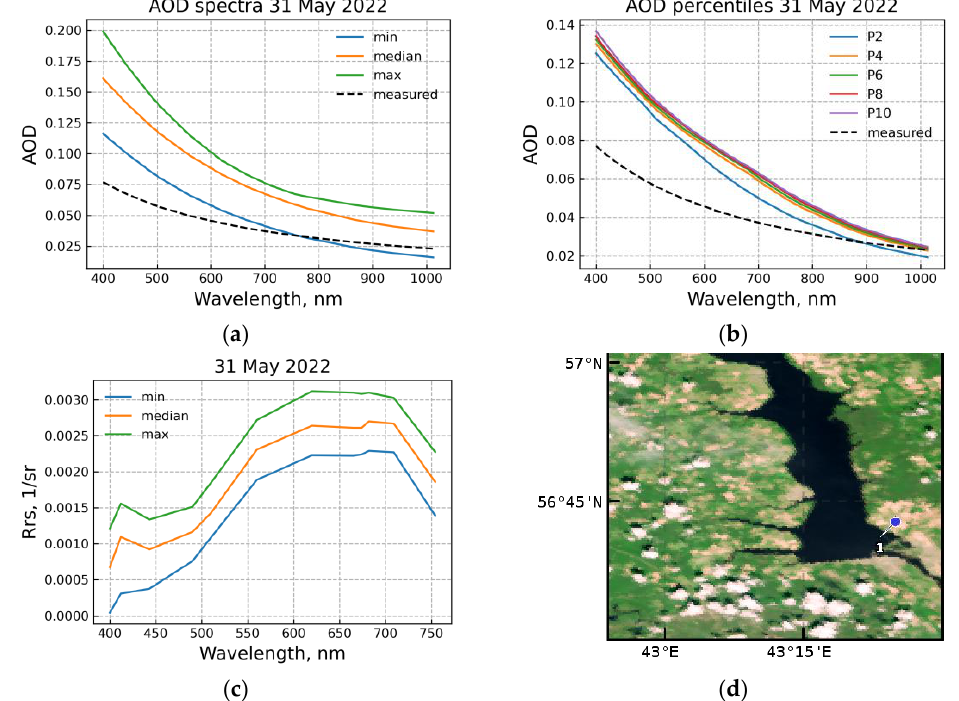
Figure 6. AOD and R rs spectra retrieved from the Sentinel-3A/OLCI image for 31 May 2022: ( a ) AOD spectra in the test region according to AC ac-2 (the minimum AOD spectrum is shown by the blue line, the median by the orange line, and the maximum by the green line) and measured AOD (black dotted line); ( b ) AOD percentiles in the test area according to AC ac-2 (P2, P4, P6, P8, and P10 are the second, fourth, sixth, eighth, and tenth percentiles, respectively) and measured AOD (dashed black line); ( c ) R rs spectra in the test area according to AC with fixed AOD based on the second percentile P2 (the minimum R rs spectrum is shown by the blue line, the median by the orange line, and the maximum by the green line); ( d ) Sentinel-3A/OLCI RGB composite for 31 May 2022.